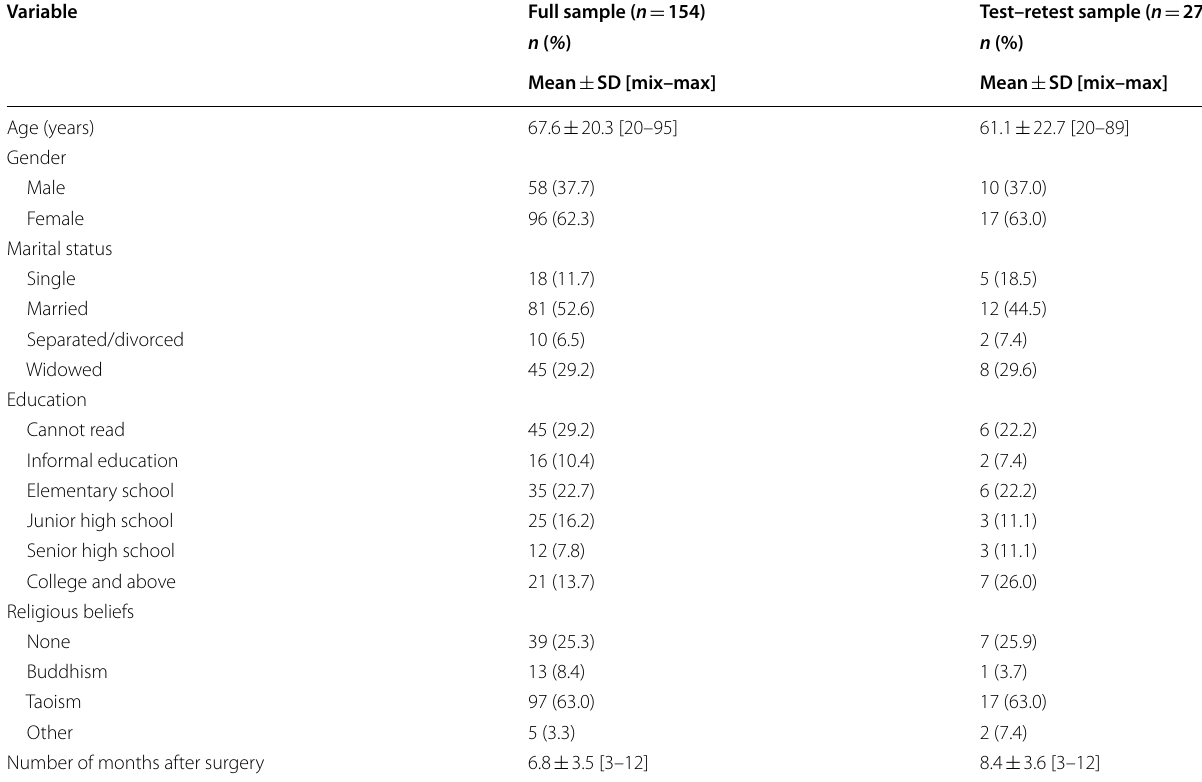
Table 1 Demographic characteristics and disease‑related